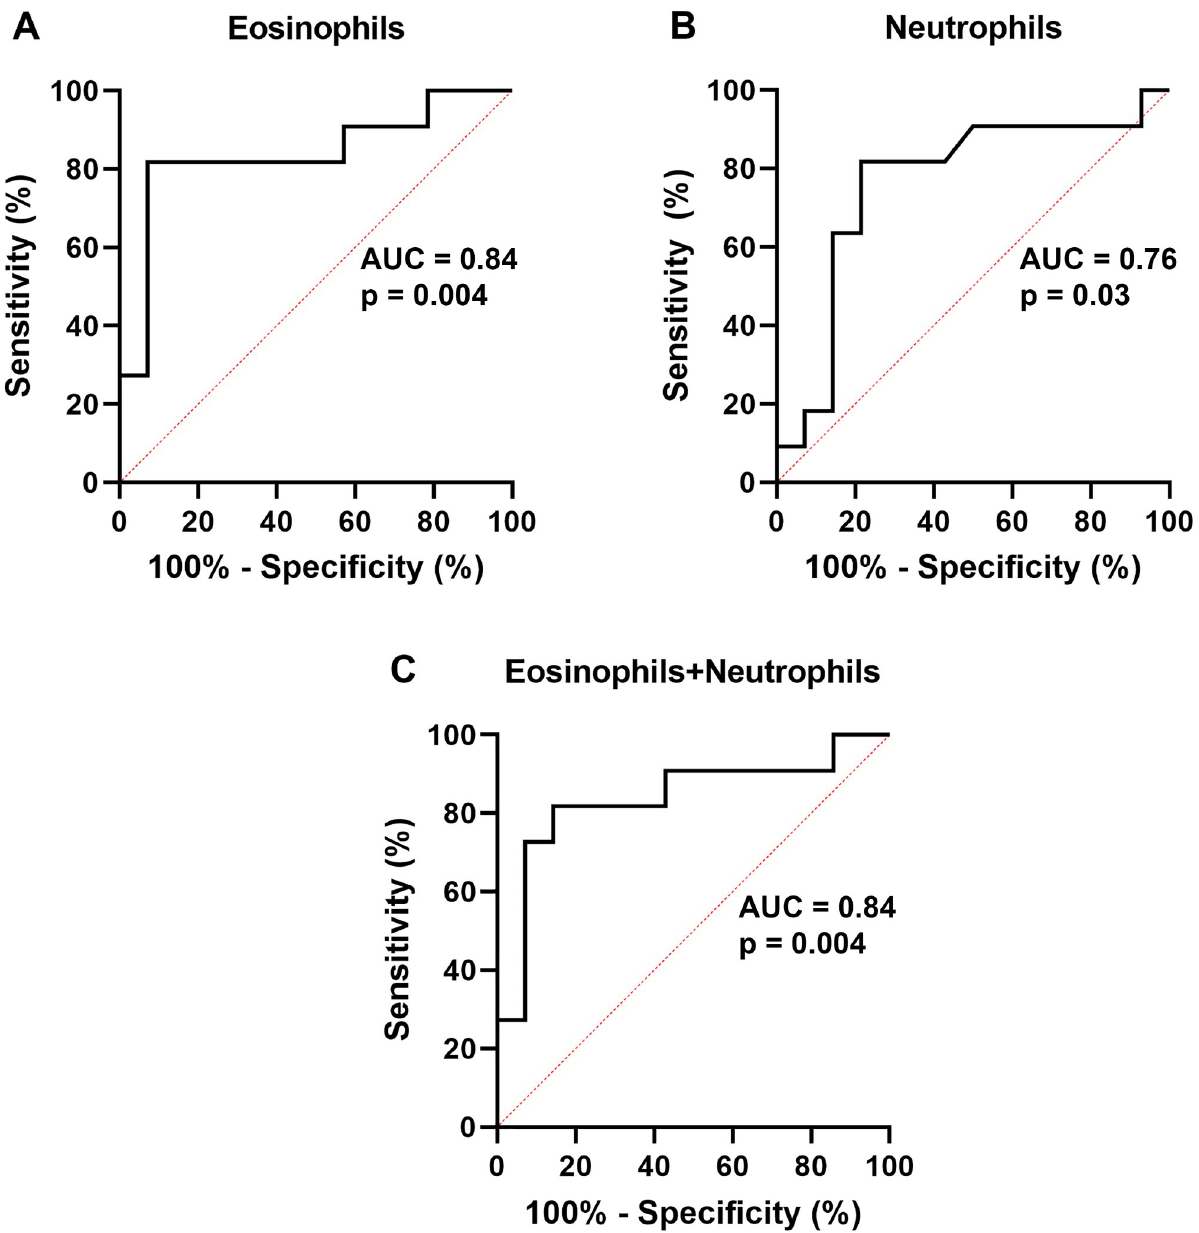
Fig 5. Receiver operating characteristic (ROC) curves for CD41-positive leukocytes to predict PEC < 6 at V2. A) Eosinophils, B) neutrophils, C) mean of eosinophil and neutrophil values. AUC, area under curve.